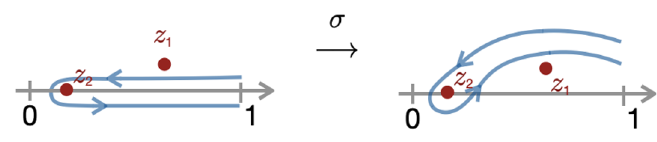
Figure 3 . Braiding e(cid:11)ect of the R